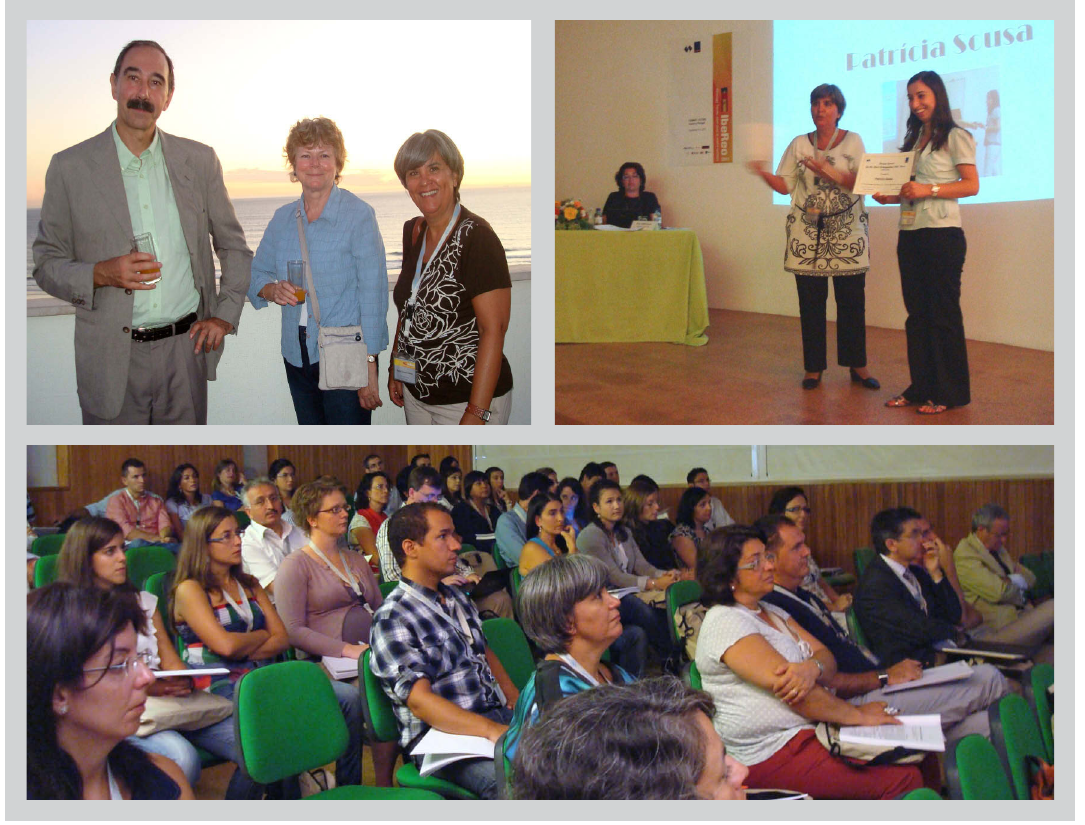
Figure 2 (left above): The Welcome cocktail (The chairperson, Teresa Cidade, and one of the invited spea- kers, Patrick Navard, and his wife). Figure 3 (right above): Iberian award to Patrícia Sousa from the Faculty of Engineering, University of Oporto, Portugal. Figure 4 (below): General view of the lecture